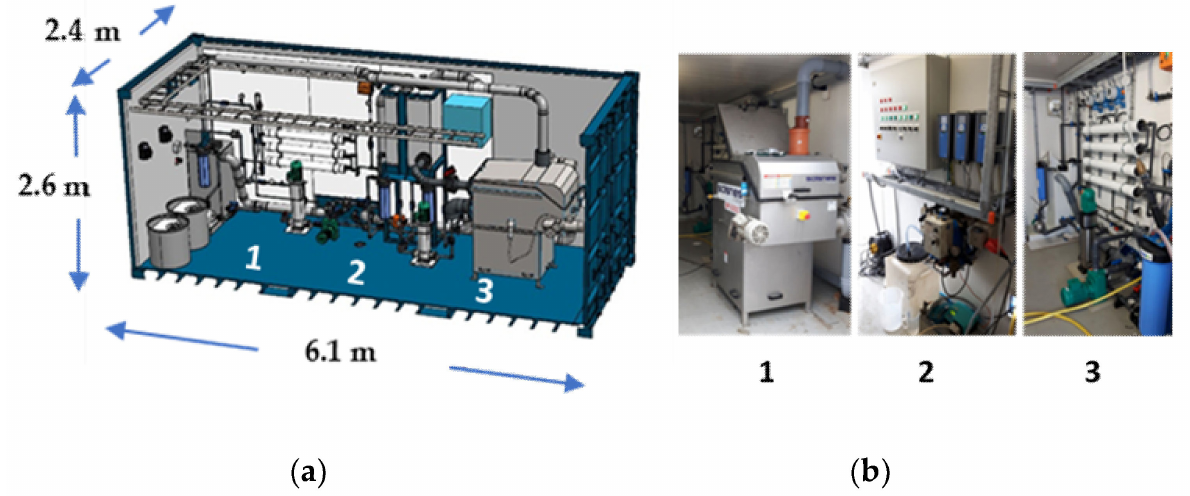
Figure 1. ( a ) A schematic of a 20-foot resource container constructed in the study: (1) Salsnes SF1000 belt filter with an integrated screw and a polymer feed system, (2) cartridge filters, and (3) a RO membrane unit; and ( b ) photos of the equipment: (1) Salsnes SF1000 belt filter with an integrated screw and a polymer feed system, (2) control center, and (3) a RO membrane unit installed to the